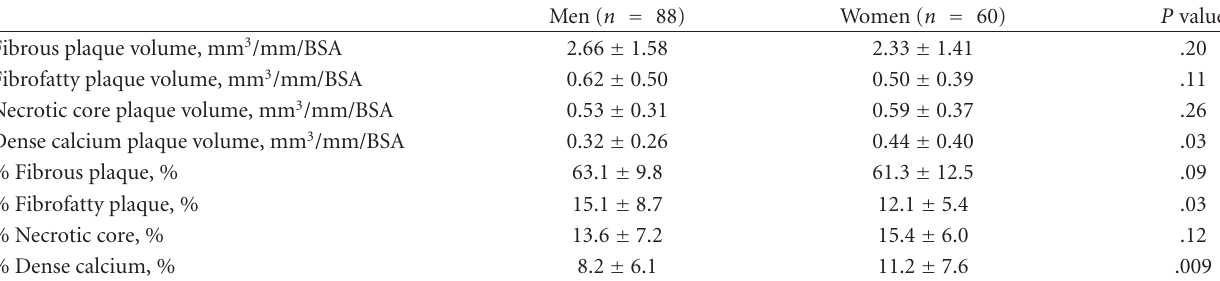
Table 3: Virtual histology-IVUS